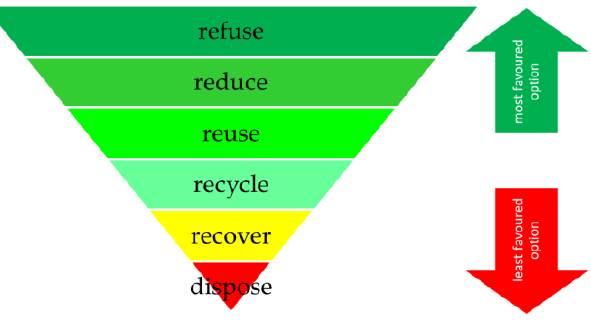
Figure 1. Waste hierarchy schematic [15,16].